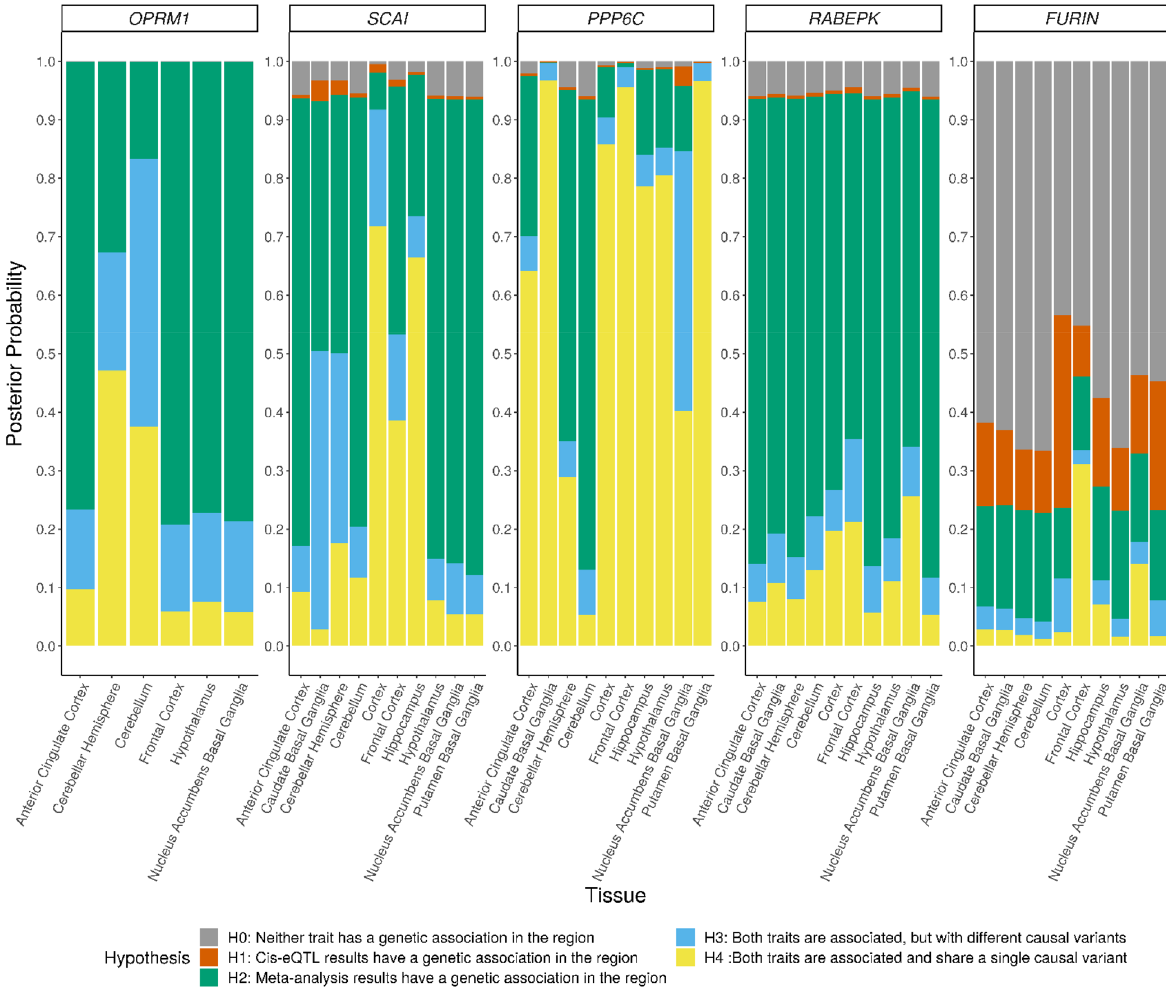
Figure 5. Colocalization of GWAS loci and QTLs for selected genes across 10 brain tissues. Posterior probabilities of supporting hypotheses regarding the association of each trait with SNPs in a region were calculated using coloc. For OPRM1 , SNP-gene cis-eQTL associations were reported in GTEx Analysis v8 for only 6 of the 10